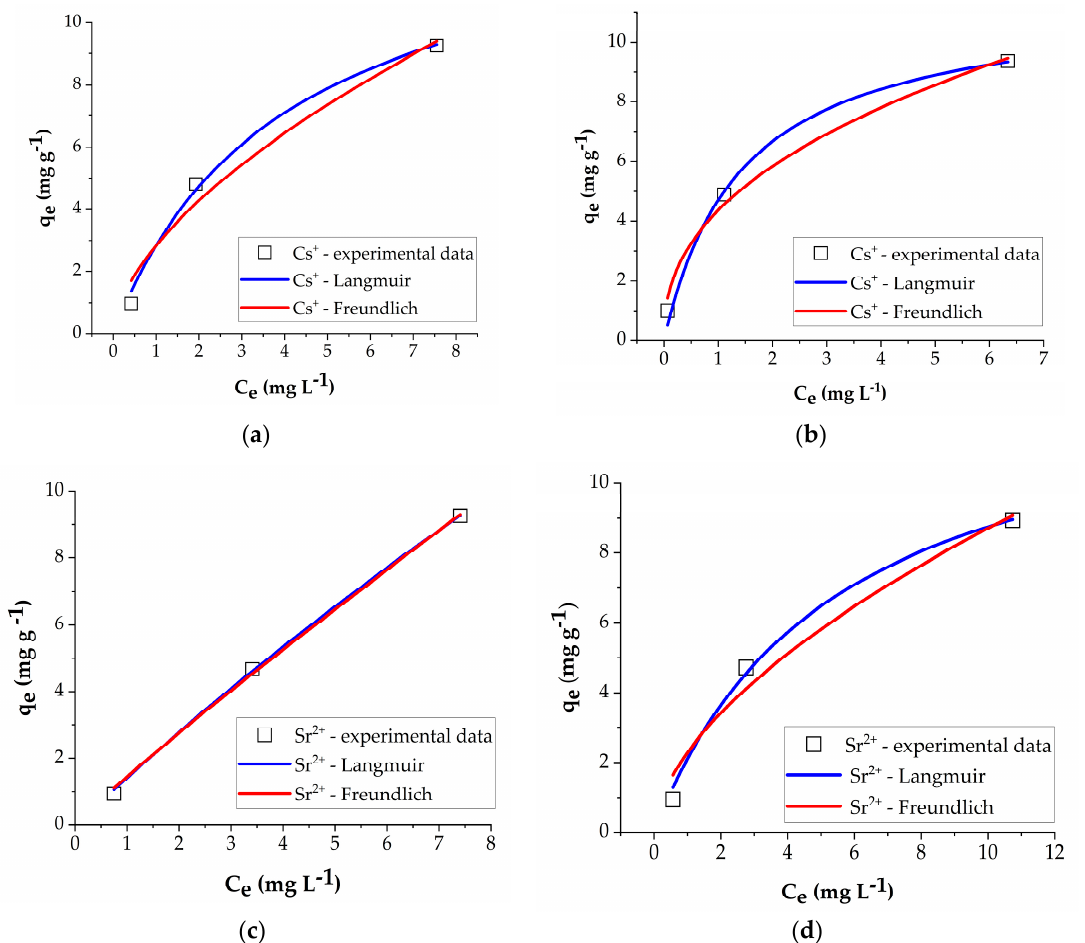
Figure 7. Nonlinear fitting of Langmuir and Freundlich isotherm models for the Cs + sorption on NZ1 ( a ), Cs + sorption on NZ2 ( b ), Sr 2+ sorption on NZ1 ( c ), and Sr 2+ sorption on NZ2 ( d ). Table 3. Langmuir and Freundlich parameters for Cs + and Sr 2+ sorption on NZ1 and NZ2 at different initial